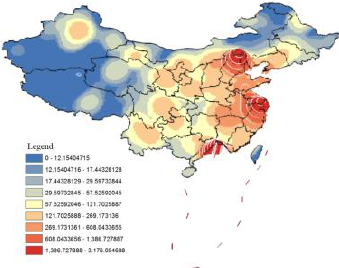
Figure 3. 3D heat map of OSM data density distribution in